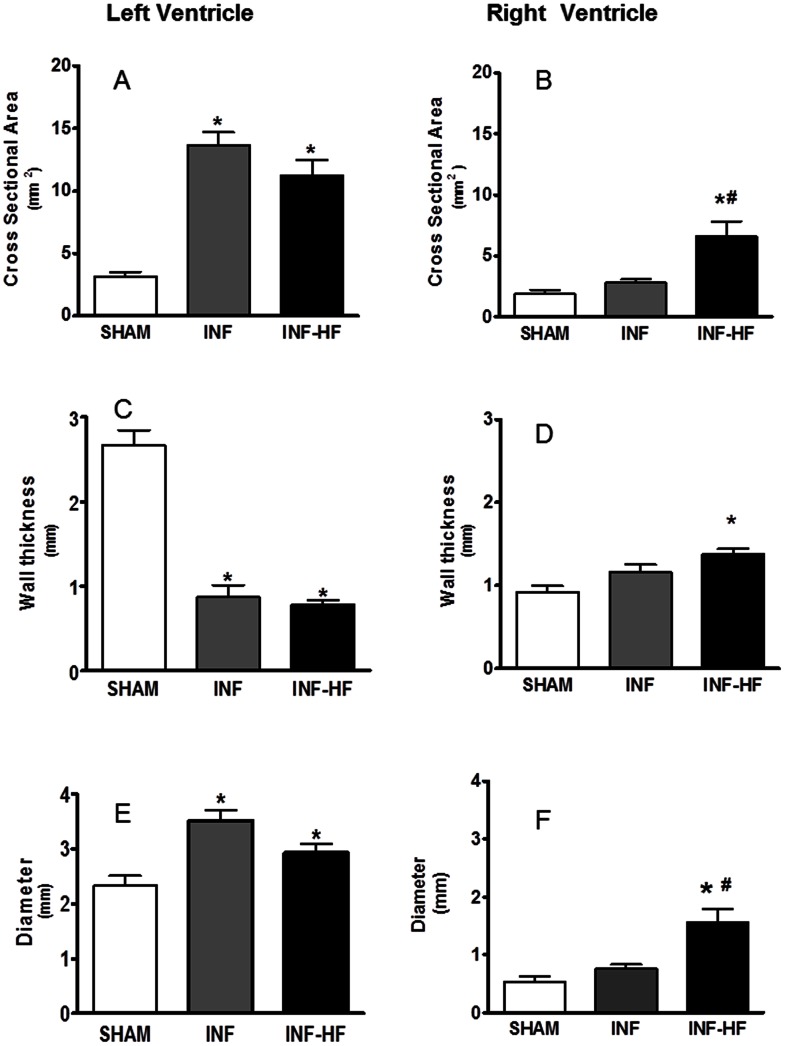
Cross sectional area and diameter of left (A and C) and right (B and D) ventricle cavities, and free wall thickness of left (E) and right (F) ventricles of sham operated rats (SHAM) and infarcted animals with (INF-HF) or without heart failure (INF) 30 days after ligation of left coronary artery.Data are mean ± S.E.M., *p<0.05 vs. SHAM group; # p<0.05 vs INF group.